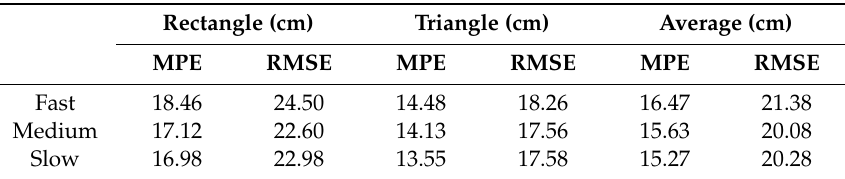
Table 5. MPE and RMSE at Di ff erent Speeds.